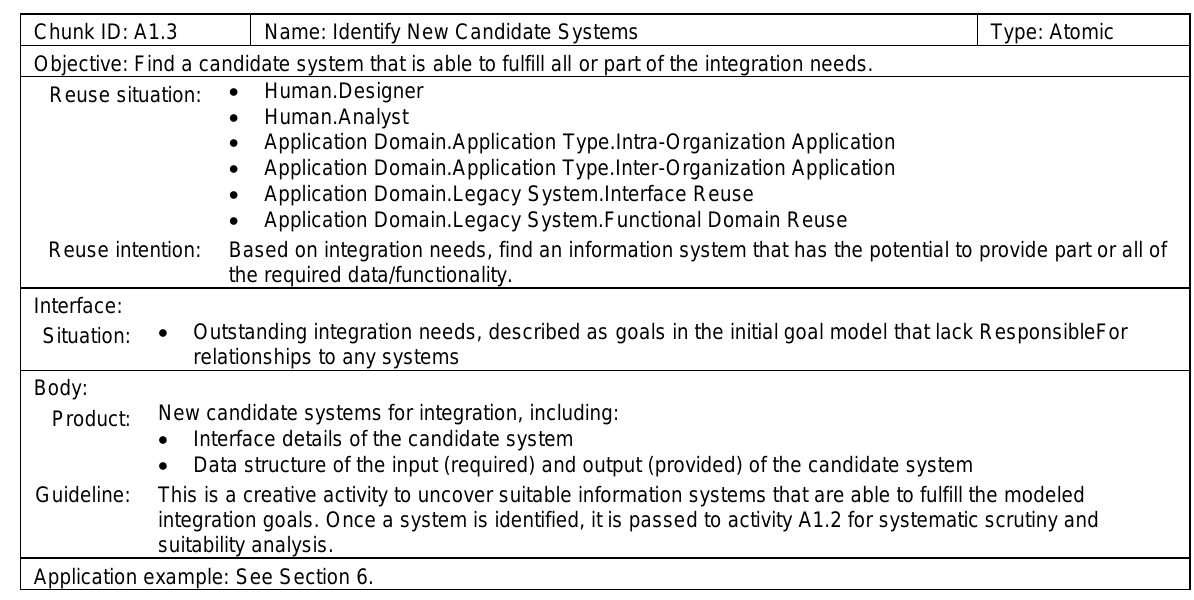
Table 3. Definition of method chunk A1.3